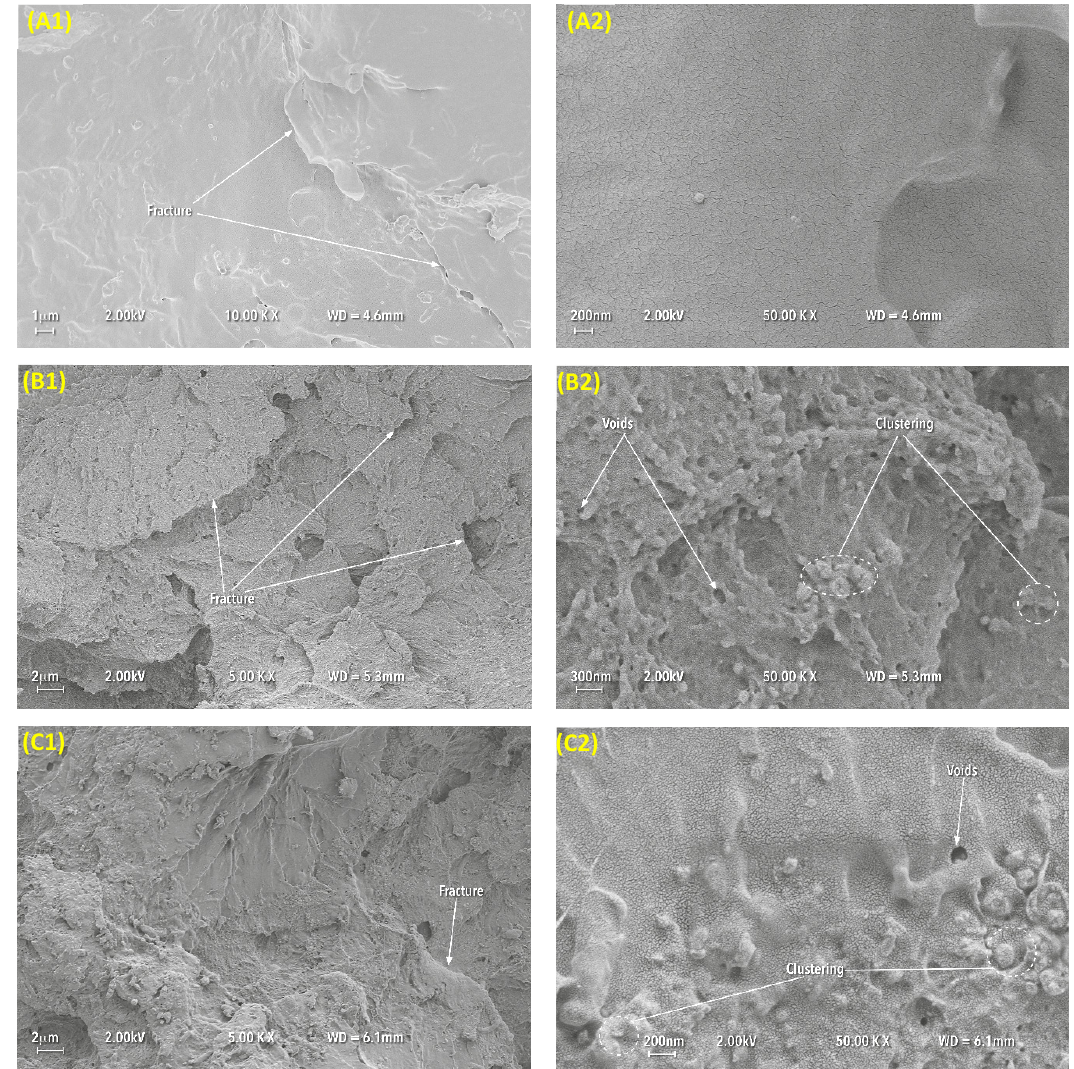
Figure 4. Representative SEM images of the fractured surfaces of impact strength test specimens at two different magnifications (1 at 10K and 2 at 50K for the control group ( A ) 0 wt%, ( B ) 5 wt% and ( C ) 10 wt% added zirconia, respectively).